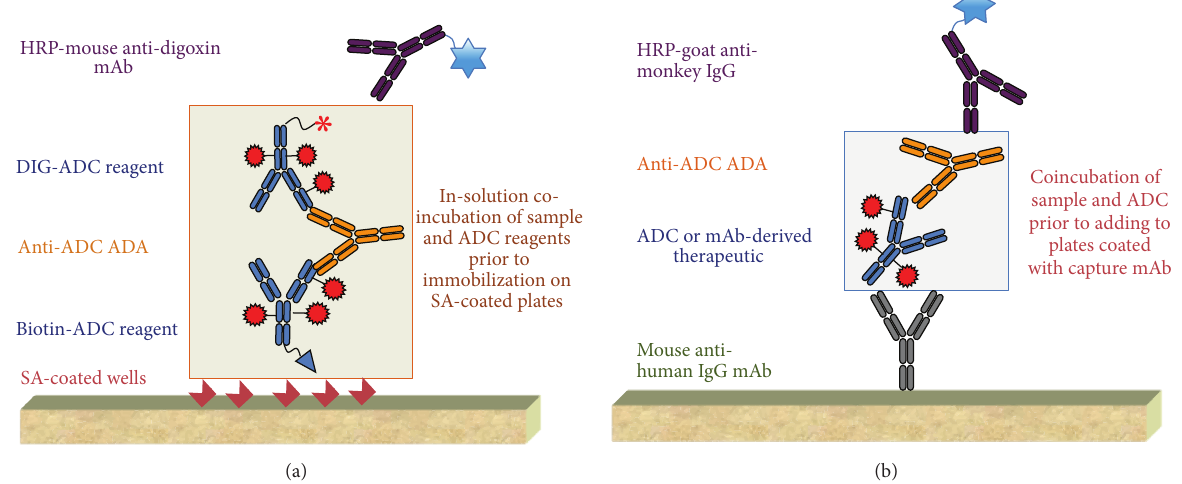
Figure 1: ADA assay formats used for cynomolgus monkeys. (a) Biotherapeutic-specific biotin-DIG ELISA used to screen ADAs in samples from two cynomolgus studies with different ADCs. In this assay, the specific ADC reagents conjugated to biotin or digoxigenin are incubated with the samples. The complexes are immobilized using streptavidin-coated plates and then detected using a mouse antidigoxin mAb conjugated to HRP. (b) Generic ADA assay format developed for ADCs and other mAb-derived biotherapeutics, also used for analysis of samples from two studies in cynomolgus monkey with different ADCs. In this generic assay, the samples are incubated with the specific biotherapeutic and the complexes immobilized onto plates coated with a mouse anti-human IgG mAb. A goat anti-monkey IgG polyclonal antibody conjugated to HRP is used for detection of the immune complexes. ADC = antibody-drug conjugate; ADAs = anti-drug antibodies; DIG = digoxigenin; ELISA = enzyme-linked immunosorbent assay; HRP = horseradish peroxidase; mAb = monoclonal antibody; SA =